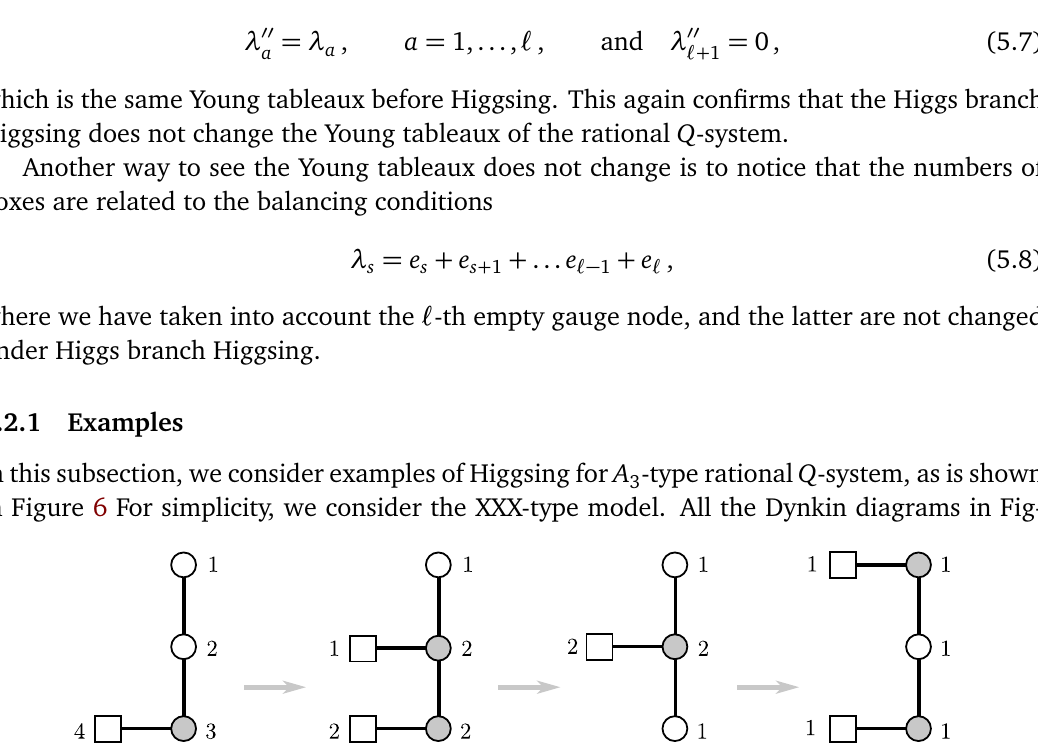
Figure 6: Higgs branch Higgsing for A spond to the Young tableaux λ = ( 1,1,1,1 )